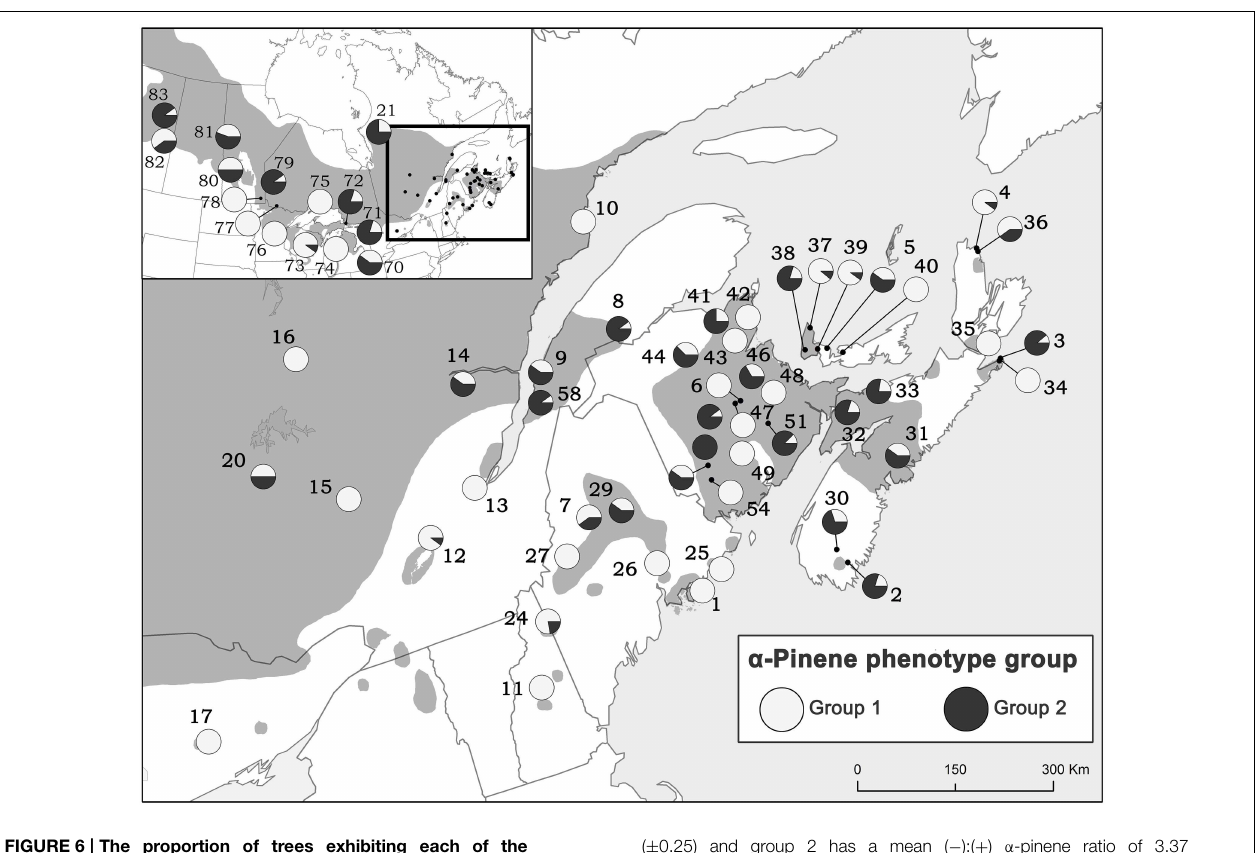
FIGURE 6 | The proportion of trees exhibiting each of the α -pinene phenotypes from all natural stands and provenance origins. Group 1 has a mean ( − ):( + ) α -pinene ratio of 1.10